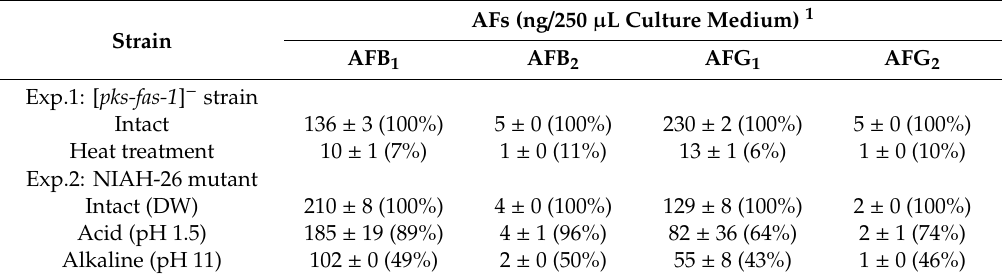
Table 4. Feeding experiments of atoxigenic mutants with HAMA pigment treated with various